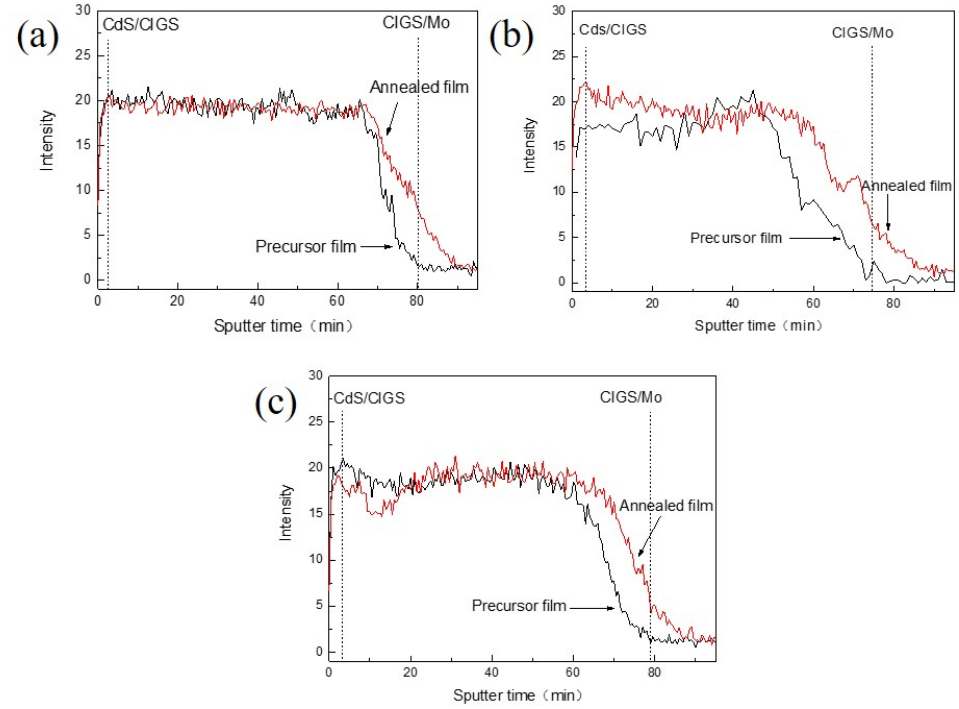
Figure 6. AES spectra of the Cu element in the precursor and annealed layers. ( a ) Structure 1, ( b ) structure 2, ( c ) structure 3.